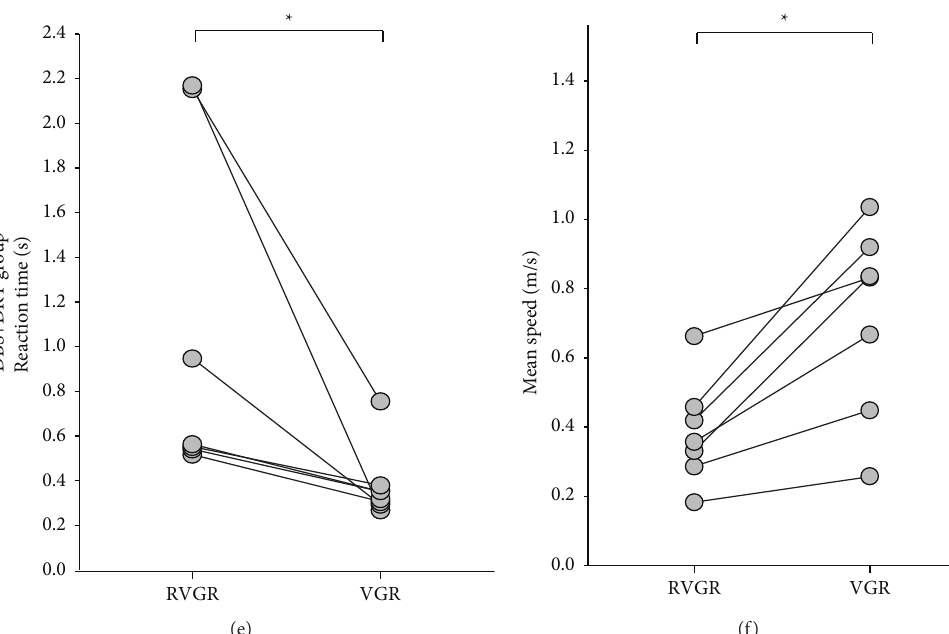
Figure 2: Changes in reaction time and mean speed in control subjects and subjects with PD off therapy. Mean reaction times were longer, and mean speeds were slower during RVGR compared to VGR in the control group ( ∗∗ P < 0 . 001) (a, b), the DRTgroup ( ∗∗ P < 0 . 001) (c, d), and the DBS +DRT group ( ∗ P < 0 . 05) (e, f). Median values with 25% and 75% quartiles and outliers (marked by black dots) are shown.